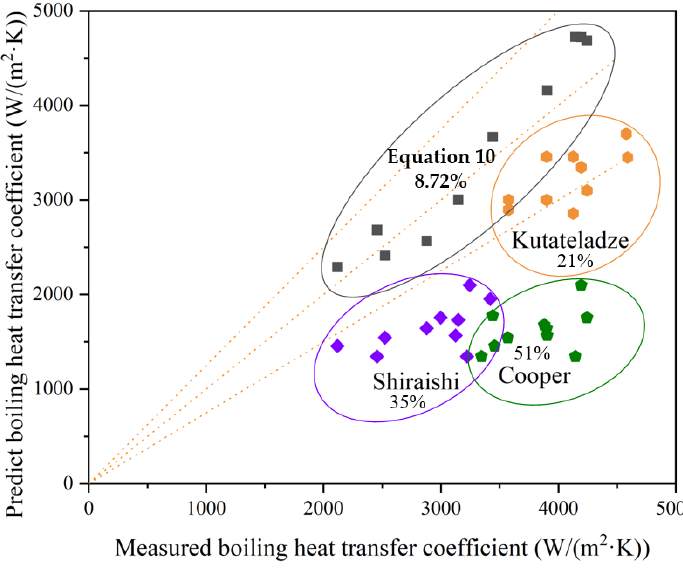
Figure 11. Comparison of different HTC prediction equations.